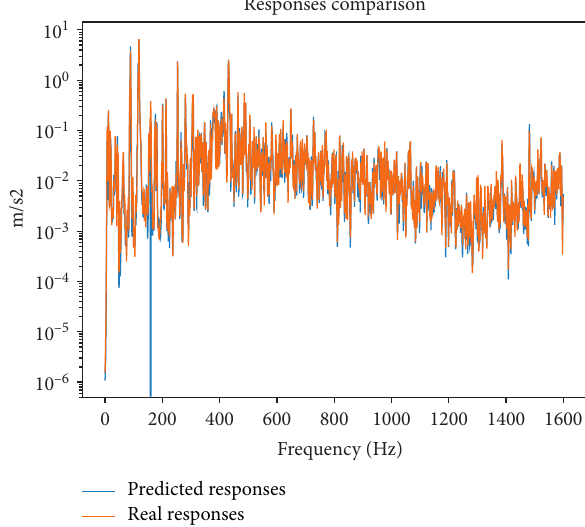
Figure 15: Comparison of predicted and real responses power spectra for the 2 nd response measurement point of the 8 th round after elastic-net